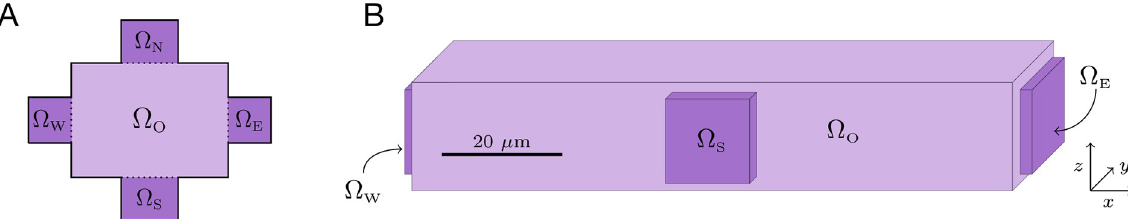
Fig 2. Cell geometry used in the simulations. A: Illustration of a two-dimensional version of a single cell. The intracellular domain is composed of the subdomains O O , O W , O E , O S , and O N . B: Three-dimensional illustration of the geometry of a single cell based on the default cell size described in Table 1.